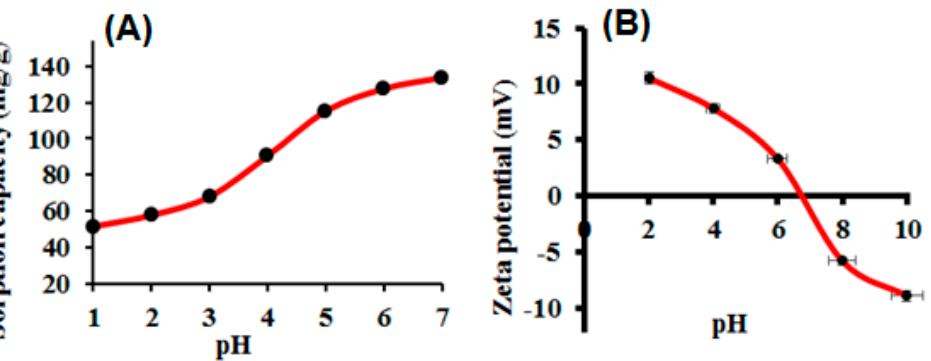
Figure 3. ( A ) Effect of sample pH on the adsorption of Hg(II); ( B ) zeta potential of CNFs@CdS (experimental conditions: flow rate = 6 mL min − 1 ; eluent = 5 mL of 0.5 M of HCl; mass of adsorbent = 50.0 mg; Hg 2+ = 250 mg L − 1 ; T = 27 °C).